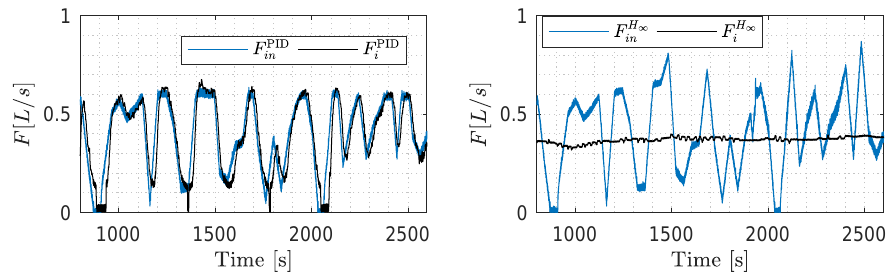
Figure 10. Comparison of flow propagation through the de-oiling system, from F in to F i , with respect to the PID control solution (top plot) and the H ∞ control solution. Analysis is based on the experimental data from Figure 9, i.e., scenario 7 (cid:13)